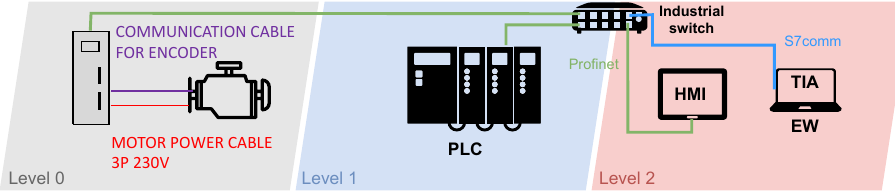
Figure 3. Diagram of industrial motor control system testbed.